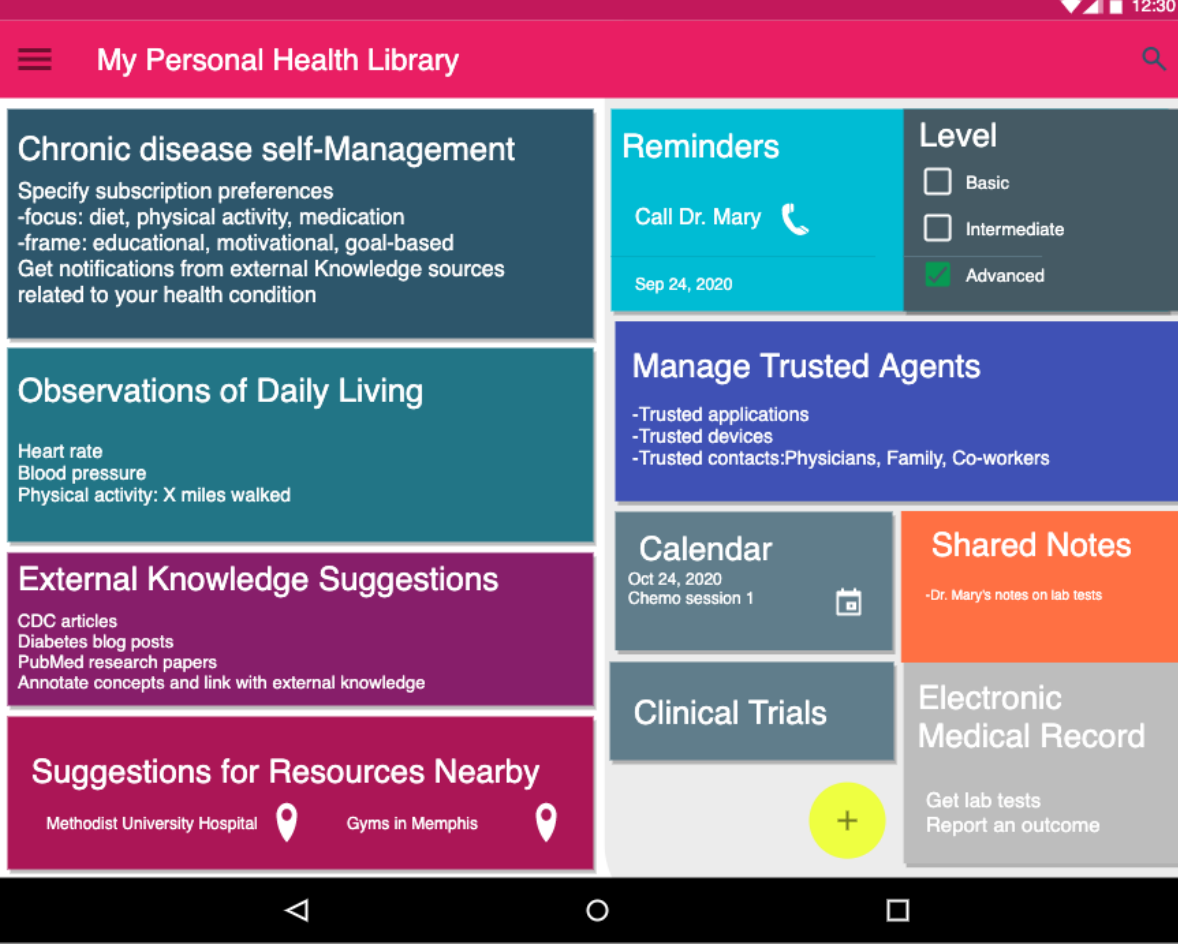
Figure 13. The PHL that enables the app in Figure 12. Through the PHL patients can perform (a) Chronic disease self-management, obtain (b) External knowledge and resource suggestions, and (c) manage trusted agents. The PHL can personalize recommendations by utilizing knowledge about monitored ODL readings, location-based detection of SDoH, external knowledge suggestions, and EHRs. Other features include reminders of medications and shared notepads with